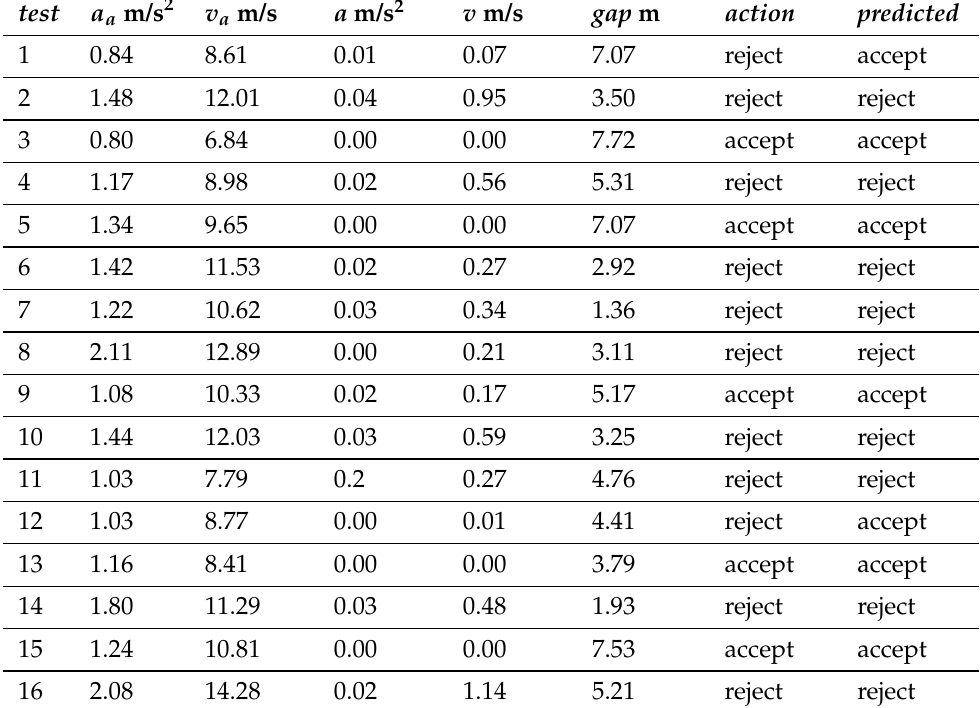
Table 3. Input values regarding the driving performance data used to predict cooperation for an EGO merging maneuver. a a and v a denote the acquired speed and acceleration values of Player prior to stopping at the last intersection, a and v are the acceleration and speed values at an instant of time right before being used to calculate the prediction, gap is the existent gap between Player and LEAD, action denotes the player’s decision, and predicted is the model prediction value.